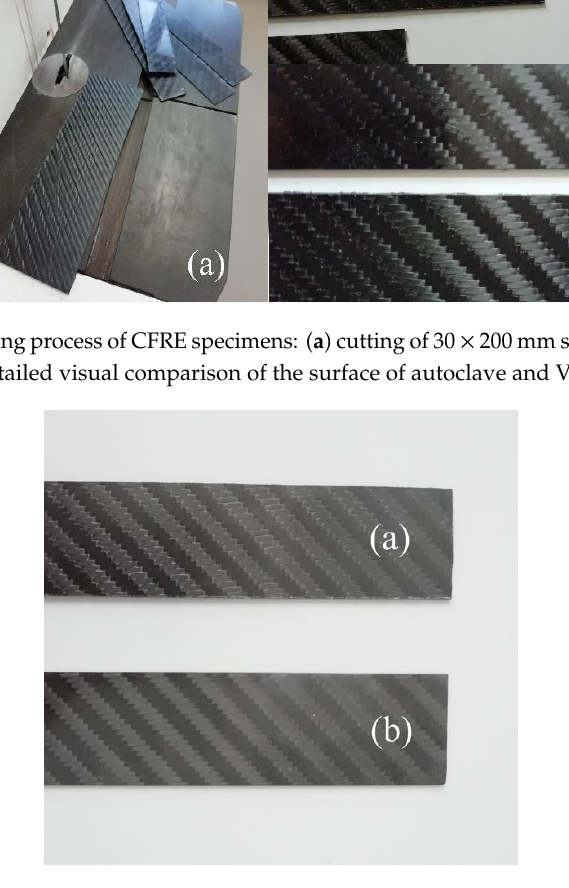
Figure 4. Manufacturing process of CFRE specimens: ( a ) cutting of 30 × 200 mm specimens; ( b ) finished specimens; and ( c ) detailed visual comparison of the surface of autoclave and VBO top surfaces.